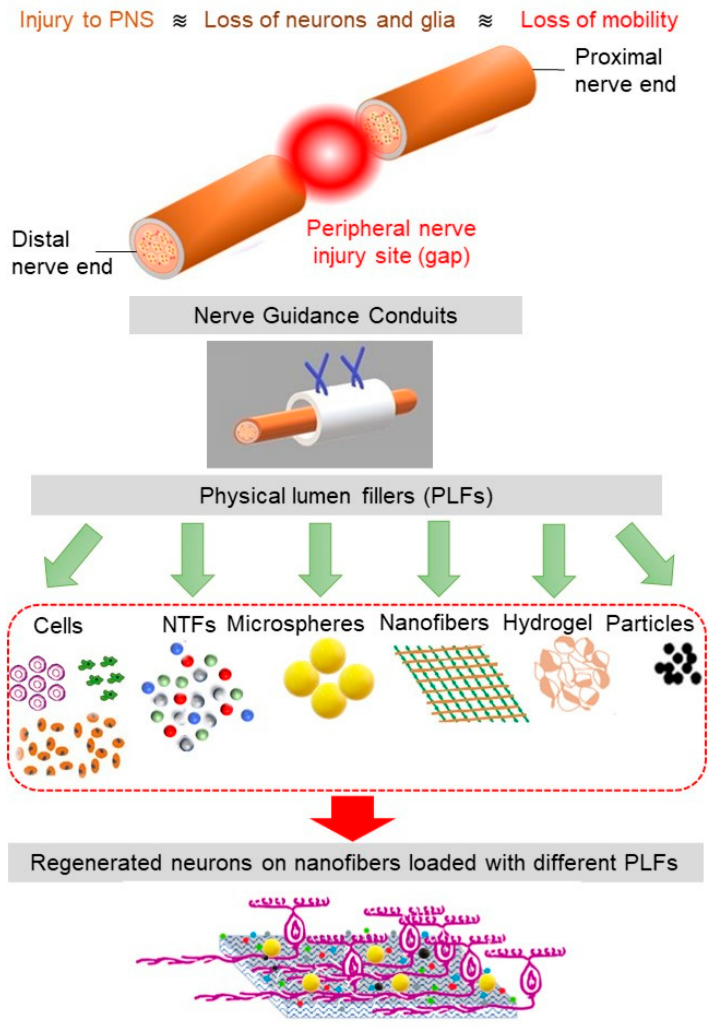
Figure 2. The schematics of PNS damage, NGC, and various physical lumen fillers (PLFs). The nanofibers loaded with the appropriate combination of PLFs facilitate cell regeneration.